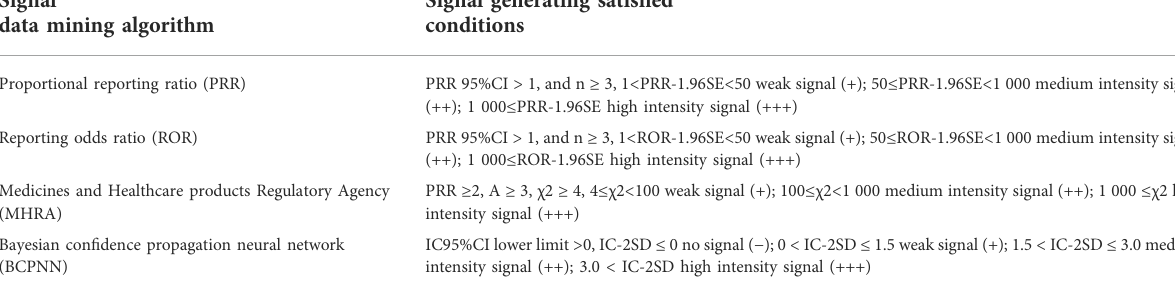
TABLE 1 Signal data mining algorithms and their signal generating satis fi ed conditions.